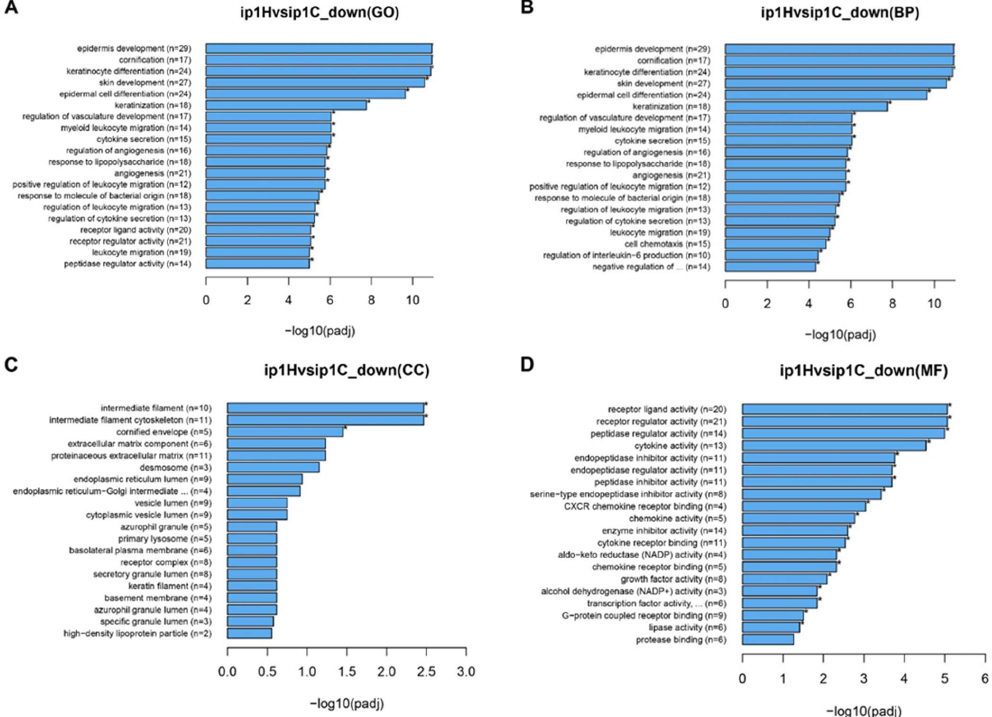
Figure 6. Top 20 enriched genes in the GO enrichment analysis in paired tumor treated with HCFs and control tumors not treated with films. Tumor tissues were obtained from the control (ip1C) and HCFs with 12–16 μm pores (ip1H) in SKOV3ip1 cells. ( A ) The top 20 ranked GO gene sets were downregulated in tumors treated with HCFs (ip1H) compared with that in the control (ip1C). ( B ) The top 20 ranked GO gene sets were downregulated in biological process (BP), ( C ) cellular comparison (CC), and ( D ) molecular function (MF). *, p < 0.05.